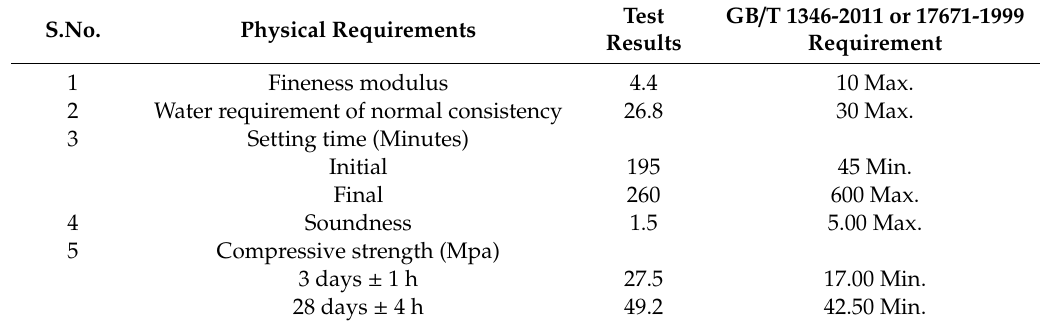
Table 2. Physical properties of OPC.